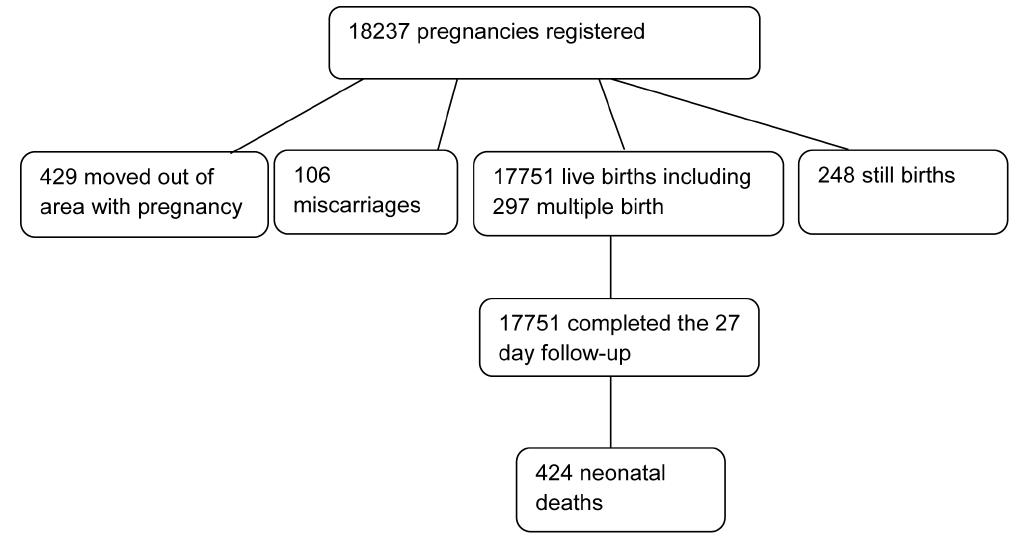
Figure 1. Study population of pregnancies registered in Navrongo HDSS: 2003–2009.